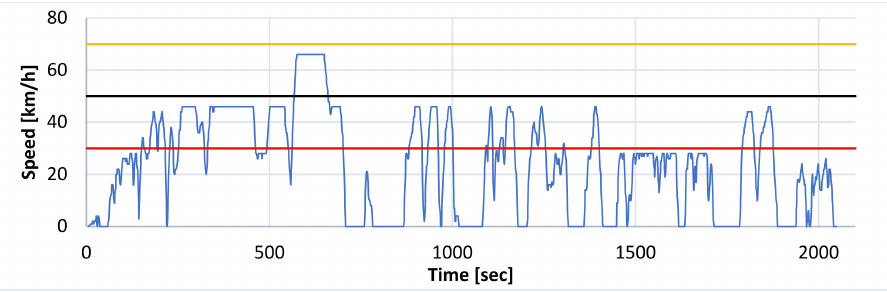
Figure 2. Speed profile for the test run “Rules”.